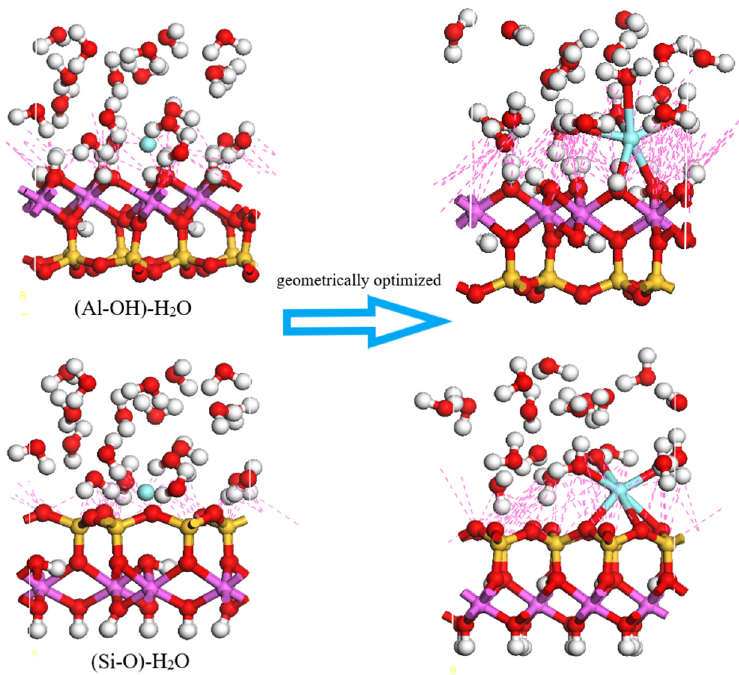
Figure 3. Geometry optimization of Y(III) on kaolinite-H 2 O interface.